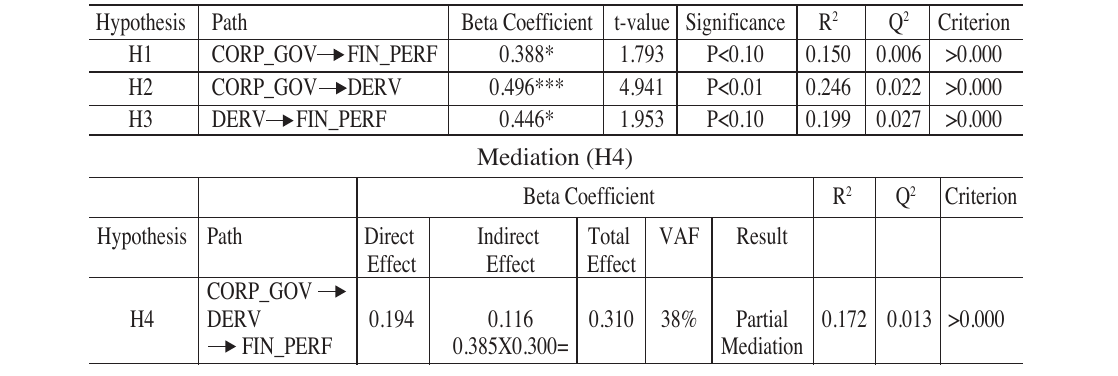
Table 17: Conditions of Mediation (H1 to H3) -2011